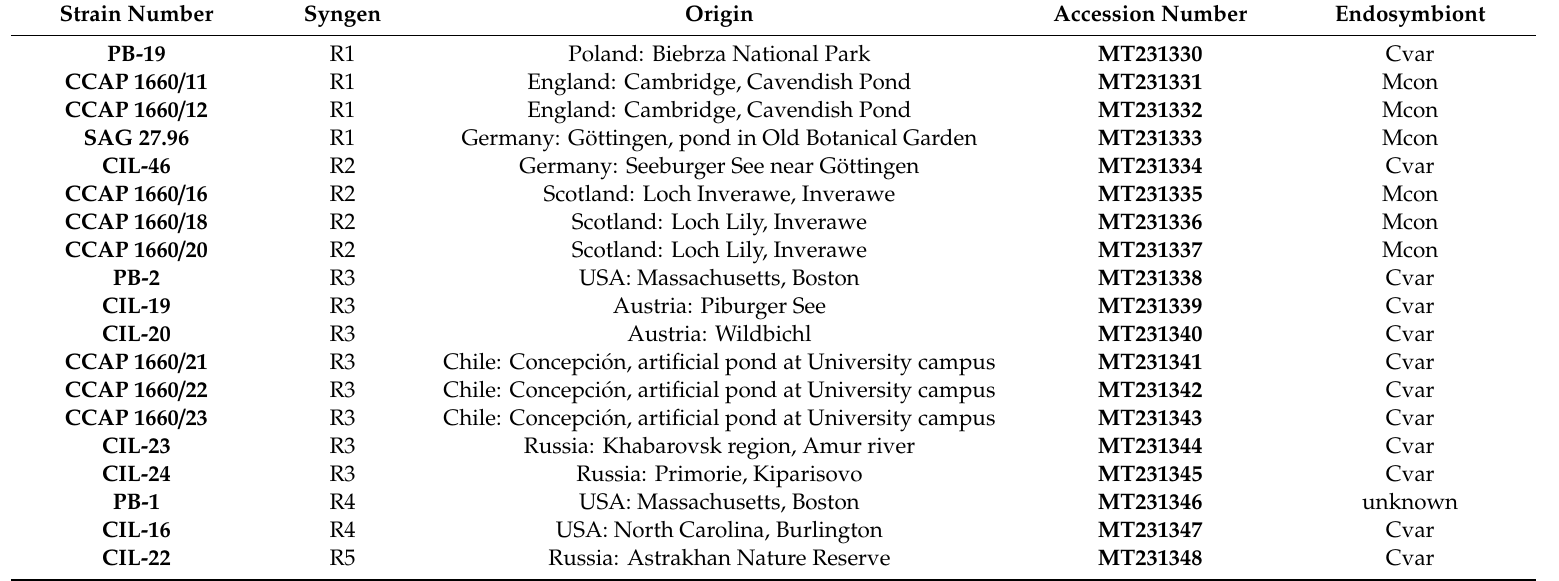
Table 1. Strain of Paramecium bursaria investigated in this